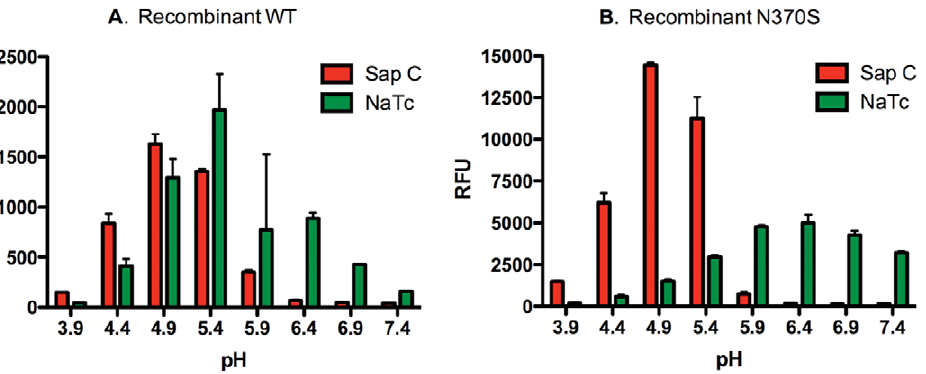
Figure 5. Effect of SapC versus NaTC on the activity of WT (A) and N370S recombinant (B) GCase. In the presence of SapC, the activity of both WT (A), N370S (B) enzyme gave a sharp peak near pH 5, compared to the broader peak and higher pH seen using NaTC.